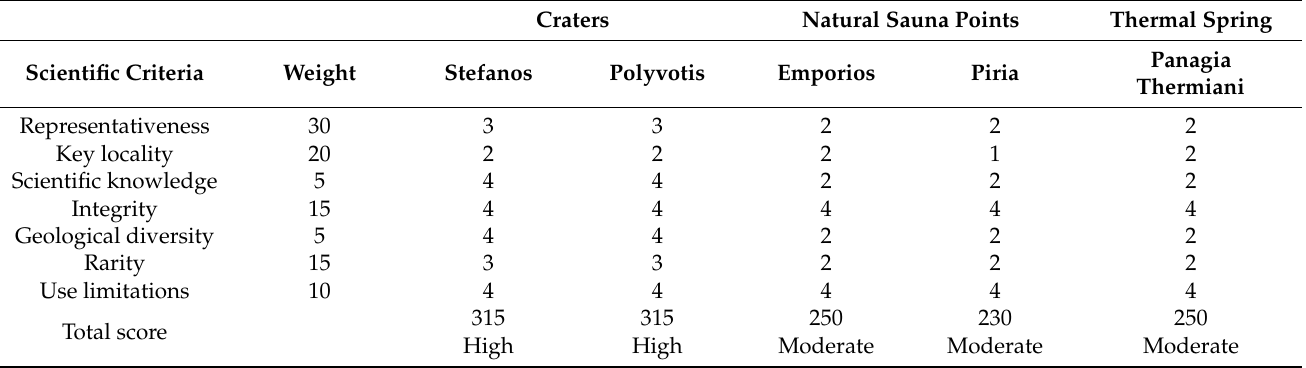
Table 2. Quantitative evaluation of geosites for scientific value (SV).